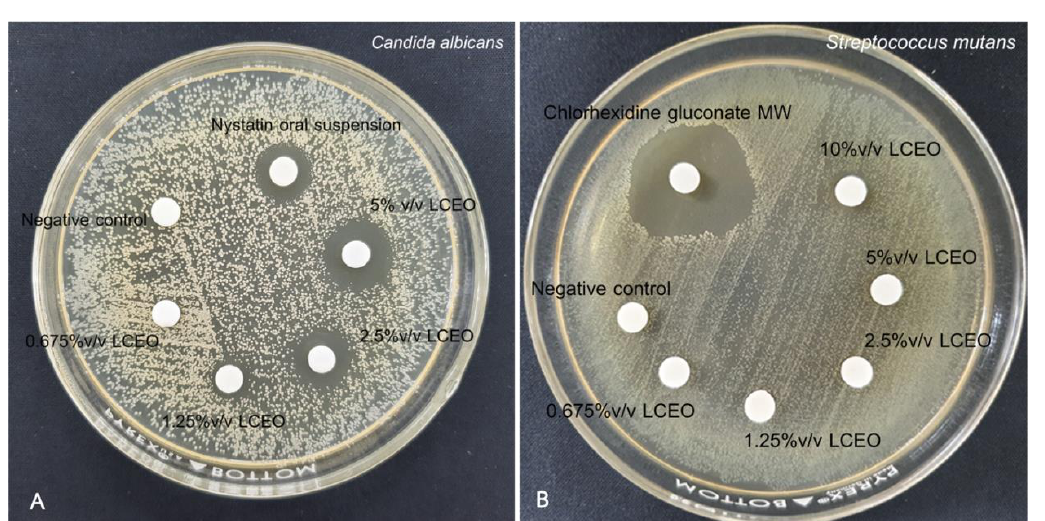
Table 3. Mean inhibition zone ± SD ( n = 5) of different concentrations of LC EO against S. mutans. Inhibition zone less than 6 mm was defined as not detected (ND).